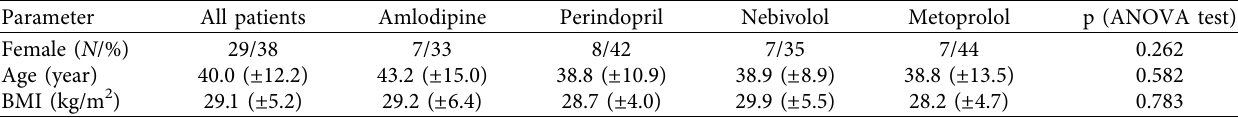
Table 1: Characteristics of the study group, means ( ± SD). N —number of women and %—the percentage of women in the group.